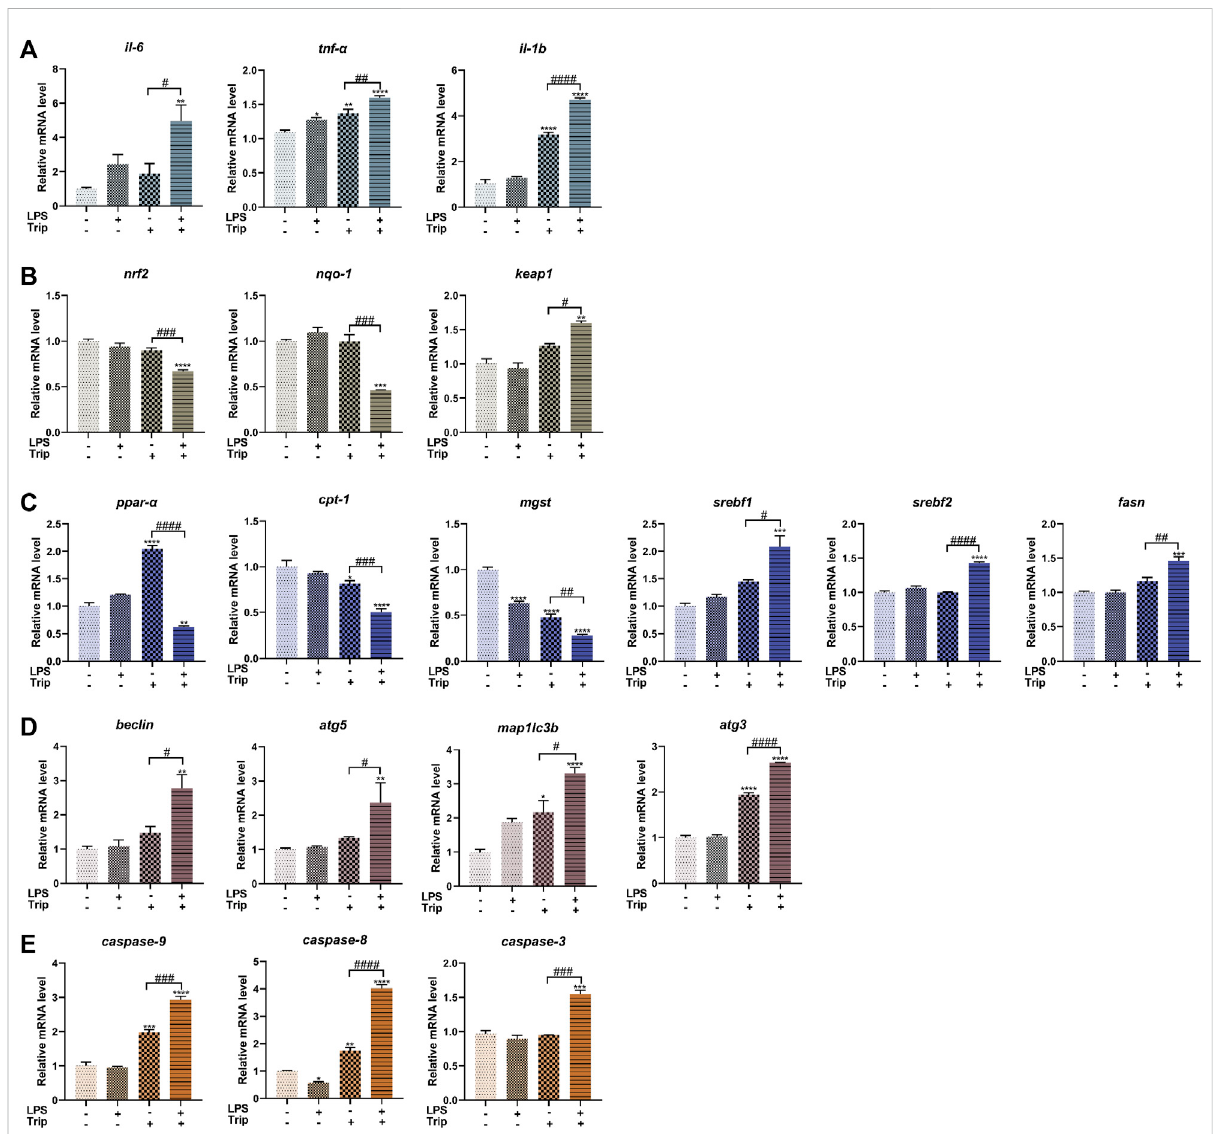
FIGURE 5 The effect of triptolide on gene expression in zebra fi sh in an in fl ammatory state. (A) In fl ammation-related genes. (B) Oxidative stress-related genes. (C) Lipid metabolism-related genes. (D) Autophagy-related genes. (E) Apoptosis-related genes. * p < 0.05, ** p < 0.01, *** p < 0.001, **** p